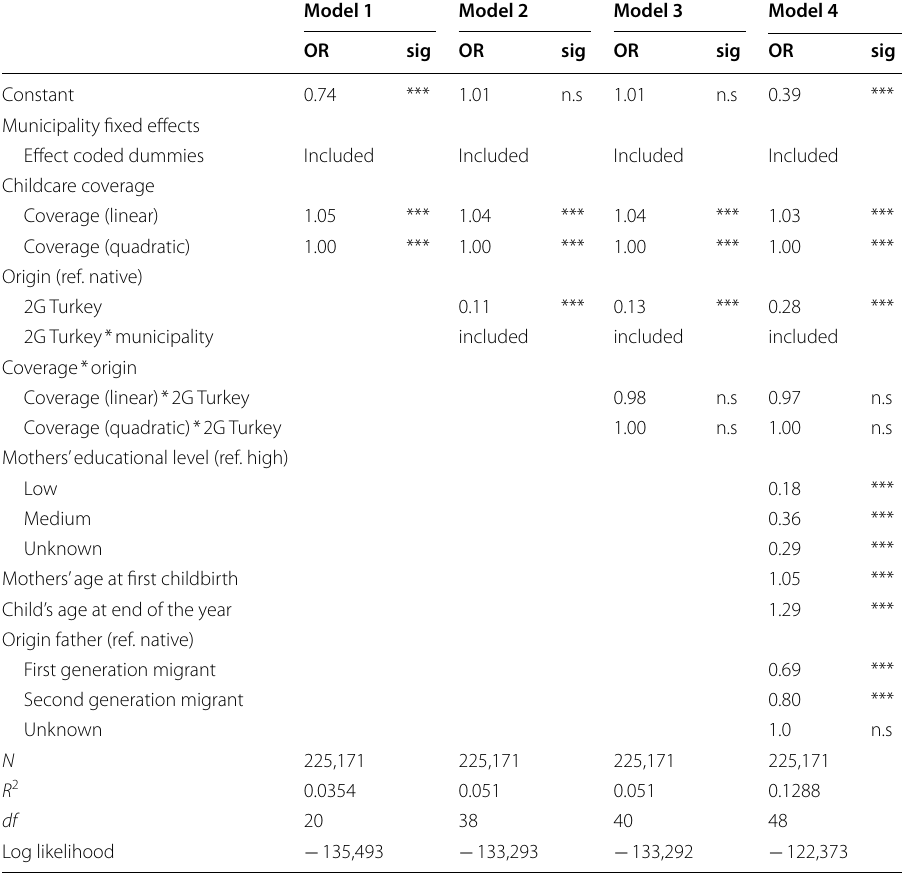
Table 4 Municipality-level fixed-effects logit models for the uptake of formal childcare, native and second generation Turkish